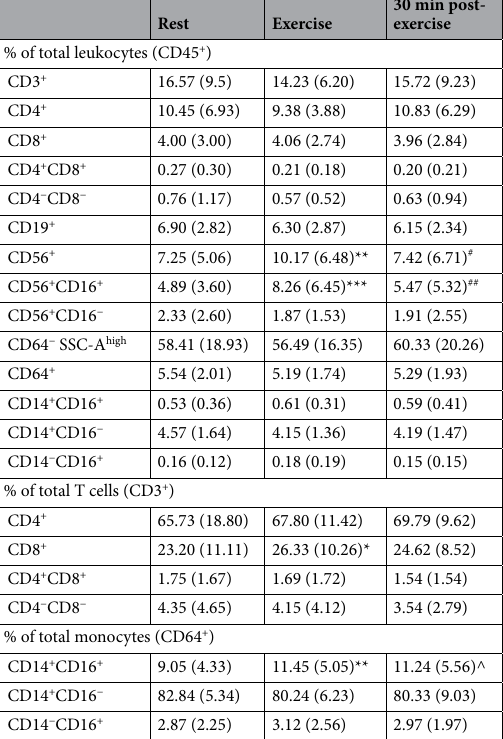
Table 1. Proportional count of immune cells in response to acute exercise. Data presented as mean (SD). Significant p values; * < 0.05 between rest and exercise; ** < 0.01 between rest and exercise; *** < 0.001 between rest and exercise; ^ < 0.05 between rest and 30 min post-exercise; # < 0.05 between exercise and 30 min post- exercise; ## < 0.01 between exercise and 30 min post-exercise.